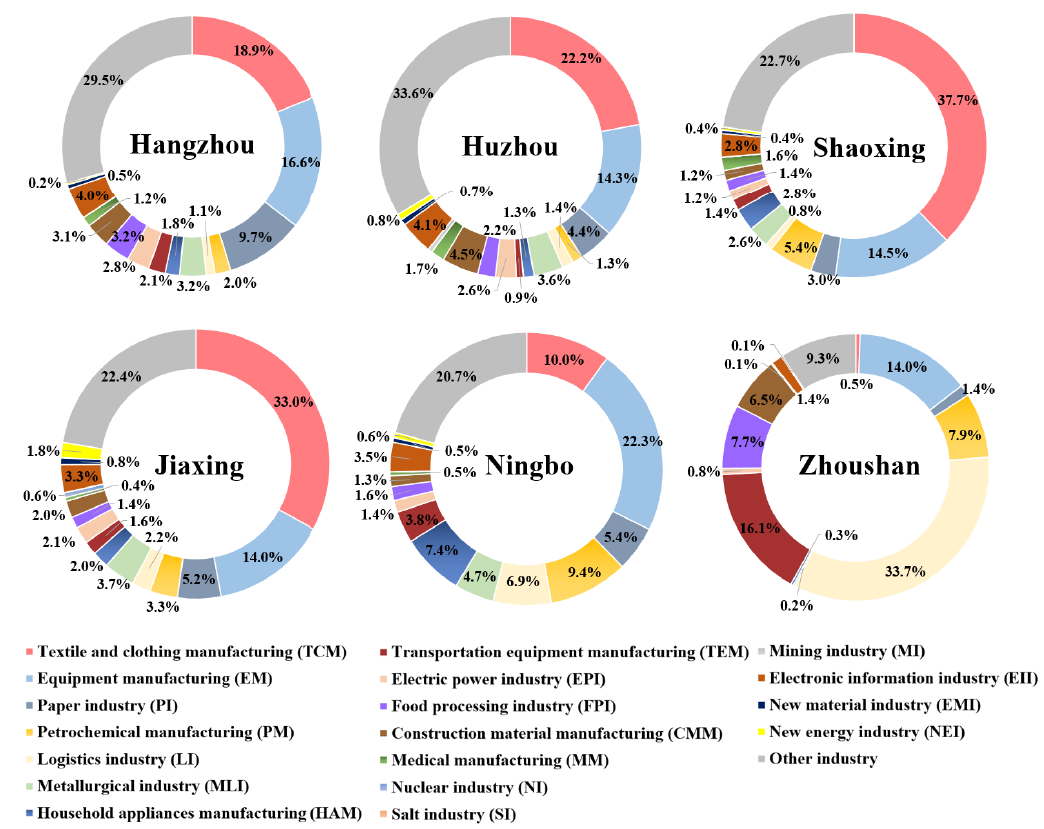
Figure 9. Industrial land-use proportions of different industrial structures across the UAHB in 2015.